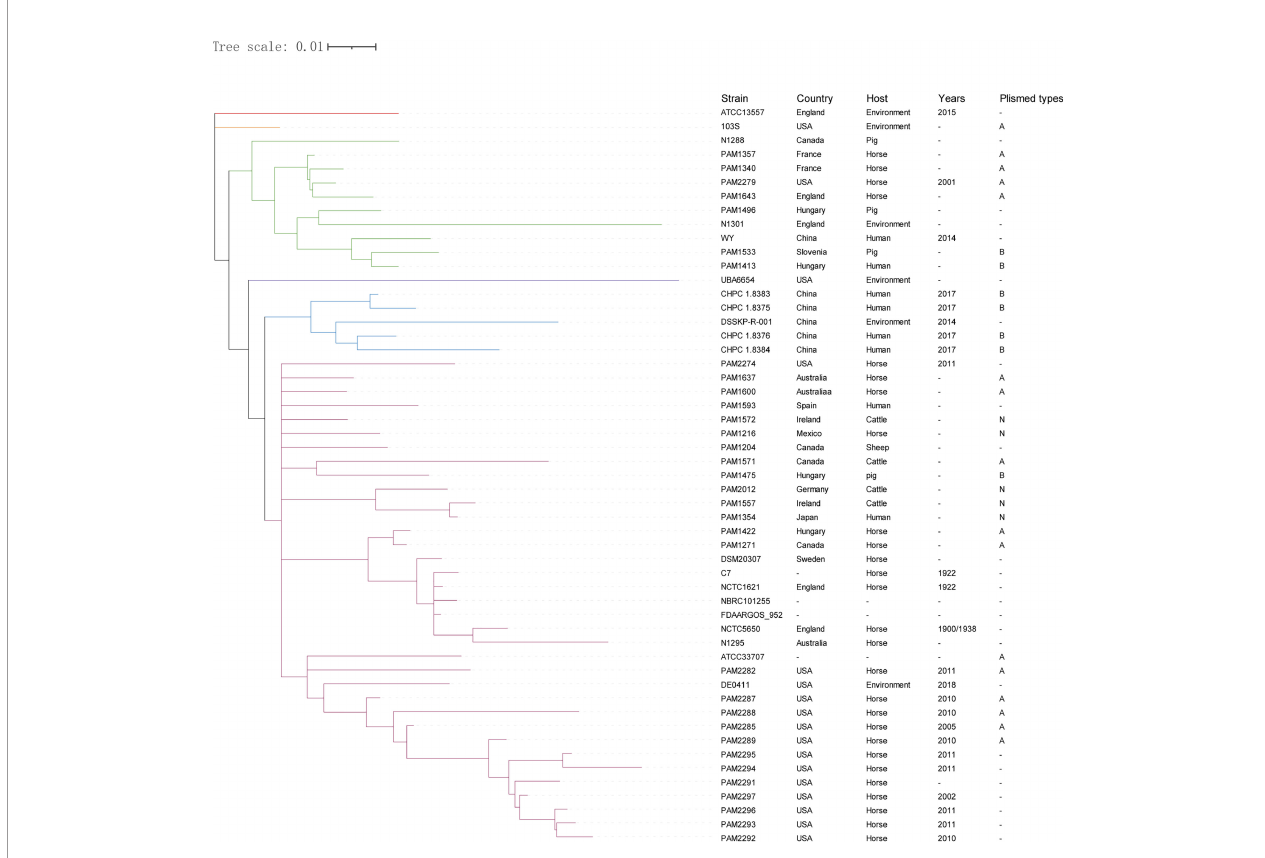
FIGURE 4 | Phylogenetic analysis of the pan- genome sequences of 53 R. equi strains. The 53 strains were divided into six clades and different clades were labeled in different colors. The isolated country, host source, isolated year and plasmid types were shown on the right. “ - ” means not